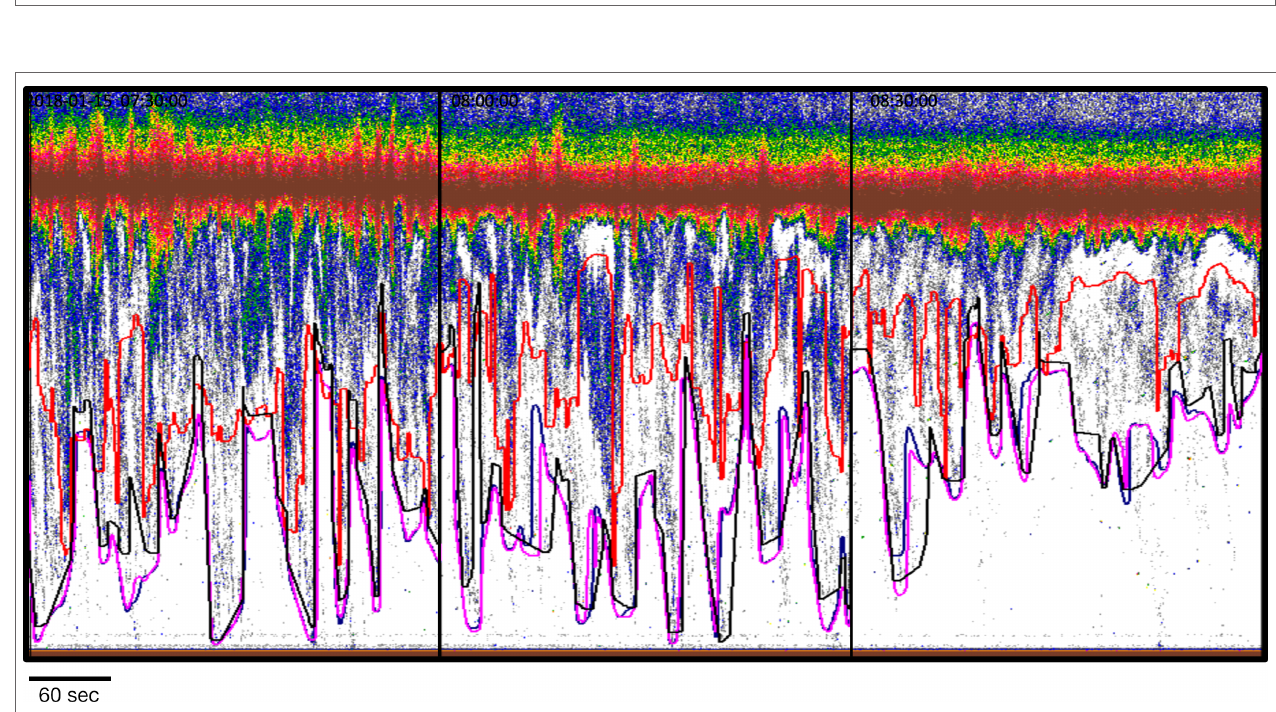
FIGURE 5 | Echogram demonstrating that the entrained-air line as calculated by the two Echofilter models (Upfacing@400ep: pink; Bifacing@700ep: blue) is a pronounced improvement over that produced by Echoview (red line), and much closer to the target line created by the analyst (black). Data: stationary data with echosounder in upfacing orientation, recorded for 5 minutes every half hour at the Minas Passage